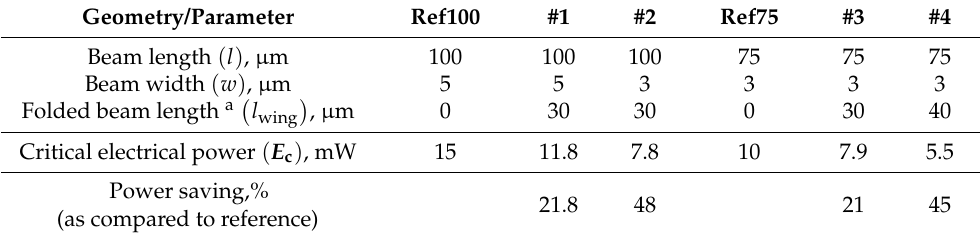
Figure 5. In situ SEM measurement of electrical resistance as a function of electrical heating power for different TiNiHf/Si microactuators. The beam length l , beam width w and length of folded beams l wing are indicated. The required electrical power to complete the phase transformation is highlighted. ( a ) Comparison of reference (top) and temperature-homogenized design (bottom), ( b ) temperature- homogenized design for different lengths of the folded beams ( l wing ) of 30 and 40 µ m. Table 2. Summary of experimental results of critical electrical power upon Joule heating required for a complete hysteresis loop and corresponding power saving for different geometries of TiNiHf/Si